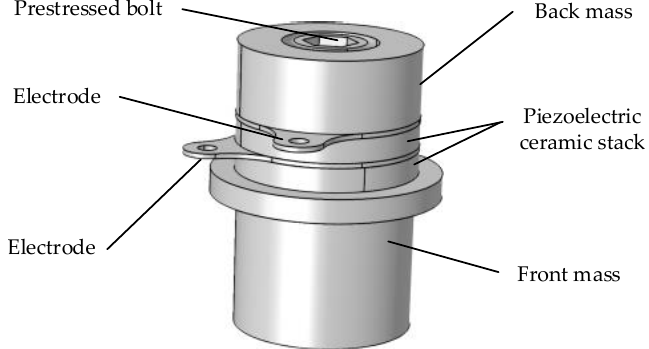
Figure 1. Structure diagram of an SPUT in longitudinal vibration.